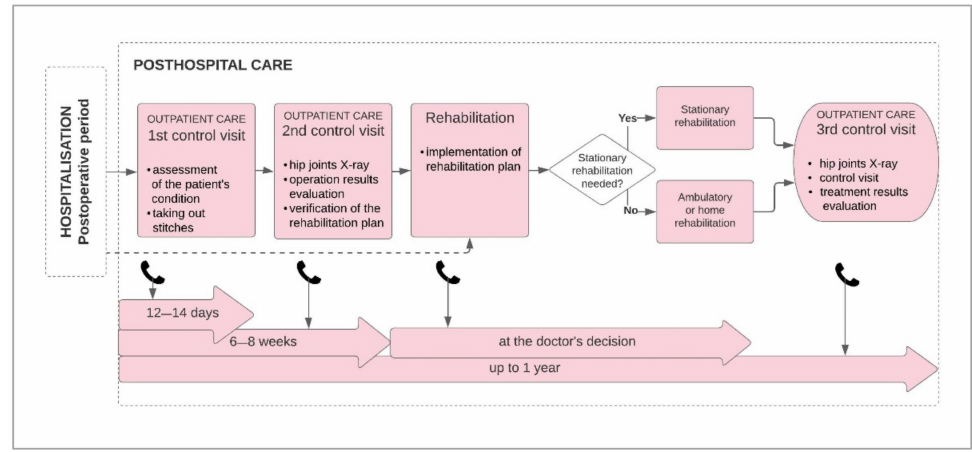
Figure 3. The last stage of the comprehensive patient care model in hip arthroplasty developed on the basis of the AOTMiT report. Source: Own